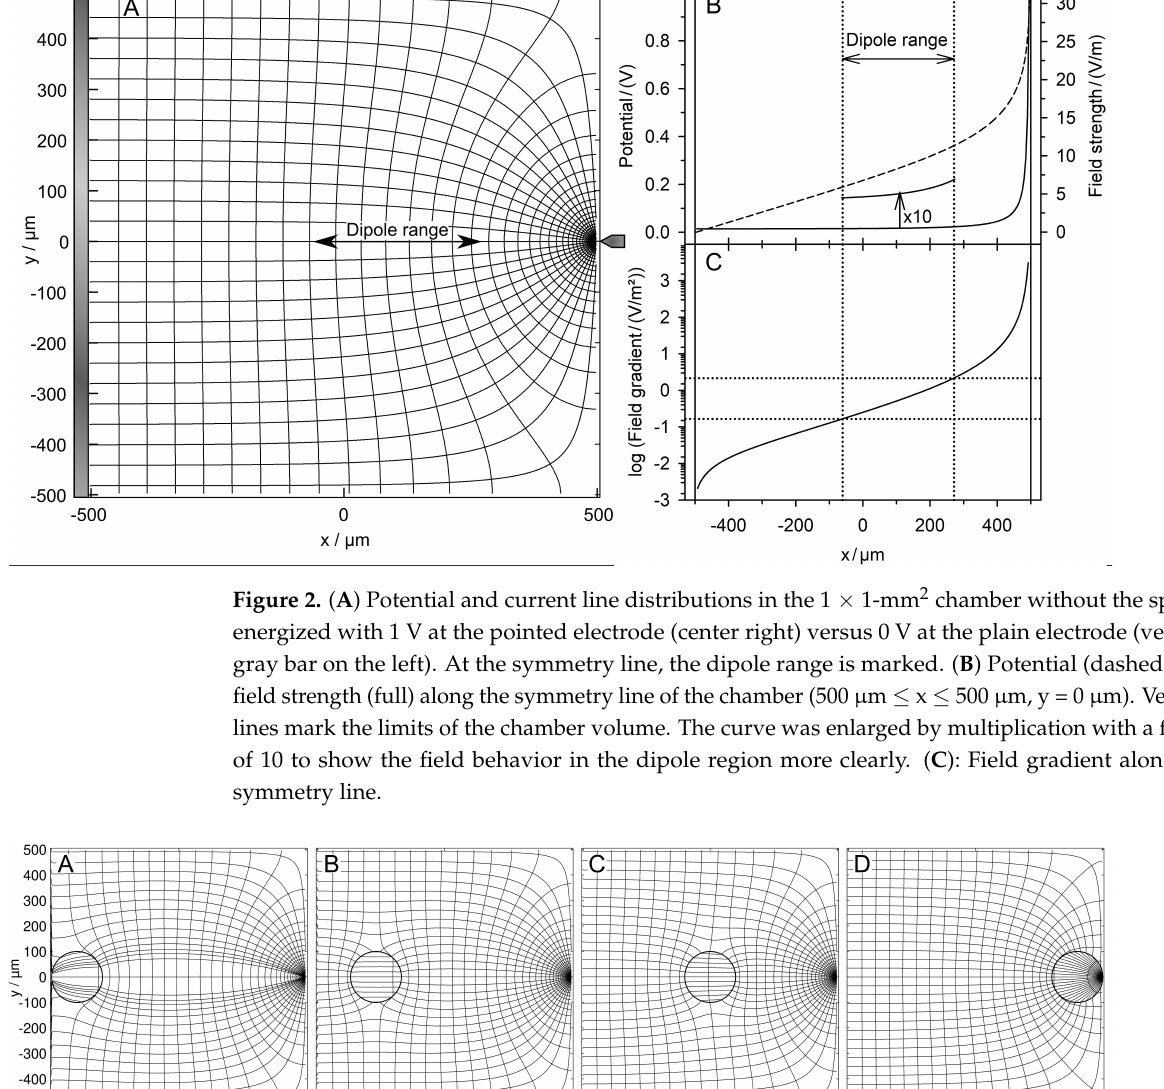
of 34.908 mS without a sphere Basic